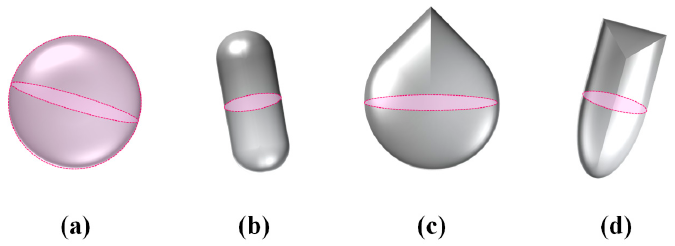
Figure 2. Examples of rigid particles having ( a ) spherical ( b ) pill-box ( c ) drop and ( d ) bullet shapes and the corresponding circular cross-sectional area (indicated by the dashed line) of radius r . Materials 2018 , 11 , x FOR PEER REVIEW